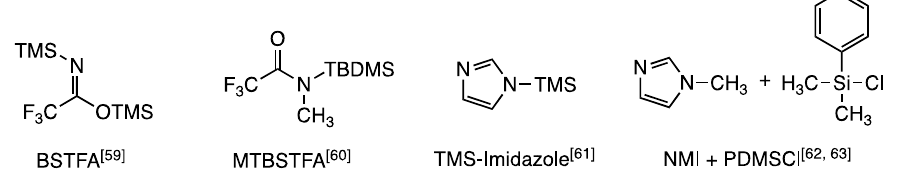
Figure 3. Commonly used silylation reagents and reagent combinations. For MTBSTFA, the reagent is provided with trimethylsilyl chloride (TMCS, 1%) as a catalytic additive. Abbreviations used: TMS = trimethylsilyl-; TBS = tert -butyldimethylsilyl-; NMI = N-methylimidazole; PDMSCl = phenyldimethylsilyl-.